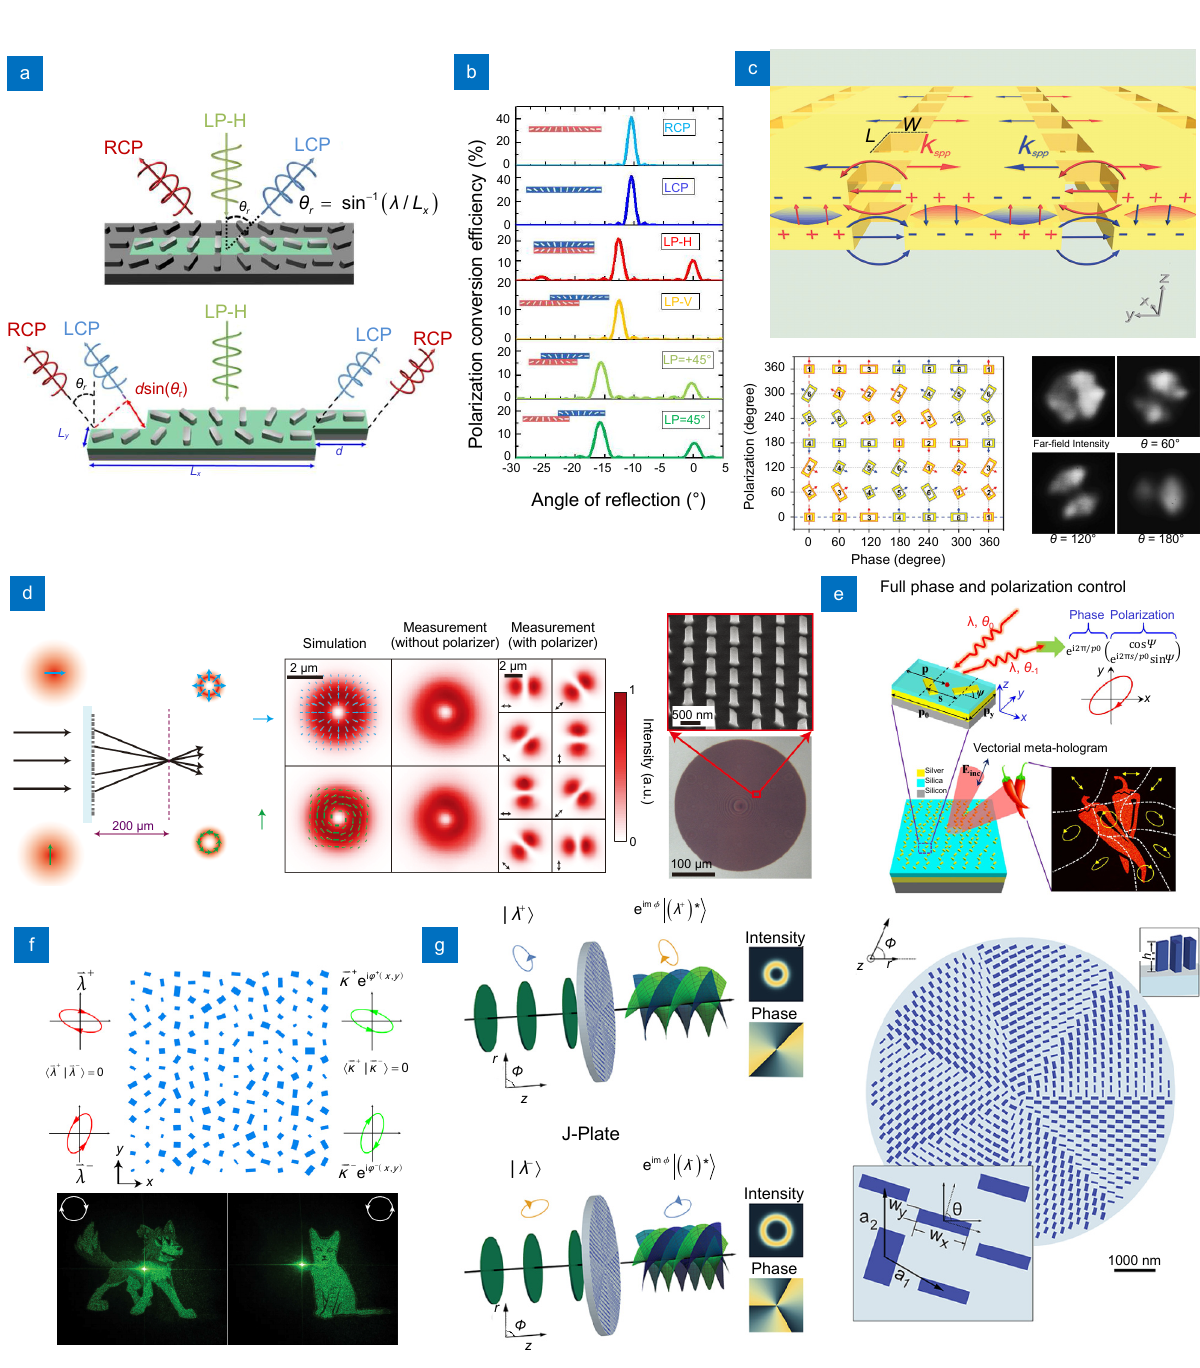
Fig. 3 | ( a ) Schematic of the reflective polarization generators based on phase gradient metasurfaces. ( b ) The simulated polarization conversion efficiency for each polarization. ( c ) Left: schematic of the bilayer nano-aperture structure used to control the polarization and phase simultaneously. Middle: schematics of the polarization and phase realized by nano-aperture pairs with various dimensions and orientations. Right: measured far-field intensity distributions of the generated radially polarized beam without and with a linear polarizer (oriented at angle θ ) intercepted before the cam- era. ( d ) Left: schematic of the metasurface that can generate and focus the radially and azimuthally polarized light for different LP incident beams. Middle: simulated and measured intensity distributions of the vector beams. Right: optical (bottom) and scanning electron (top) microscope images of the metasurface. ( e ) Schematic of the diatomic metasurface for vectorial holography. ( f ) Upper panels: schematic of the metasurface that can implement two independent and arbitrary phase profiles on any pair of orthogonal polarization states by combining both propagation phase and PB phase. Lower panels: measured images of the chiral holograms for different CP incident light. (g) Schematic of the arbitrary SOC (left) and the typical J-plate design (right). Figure reproduced from: (a–b) ref. 79 , American Chemical Society; (c) ref. 83 , Wiley-VCH; (d) ref. 85 , Nature Publishing Group; (e) ref. 87 , American Chemical Society; (f) ref. 95 , American Physical Society; (g) ref. 100 , American Association for the Advancement